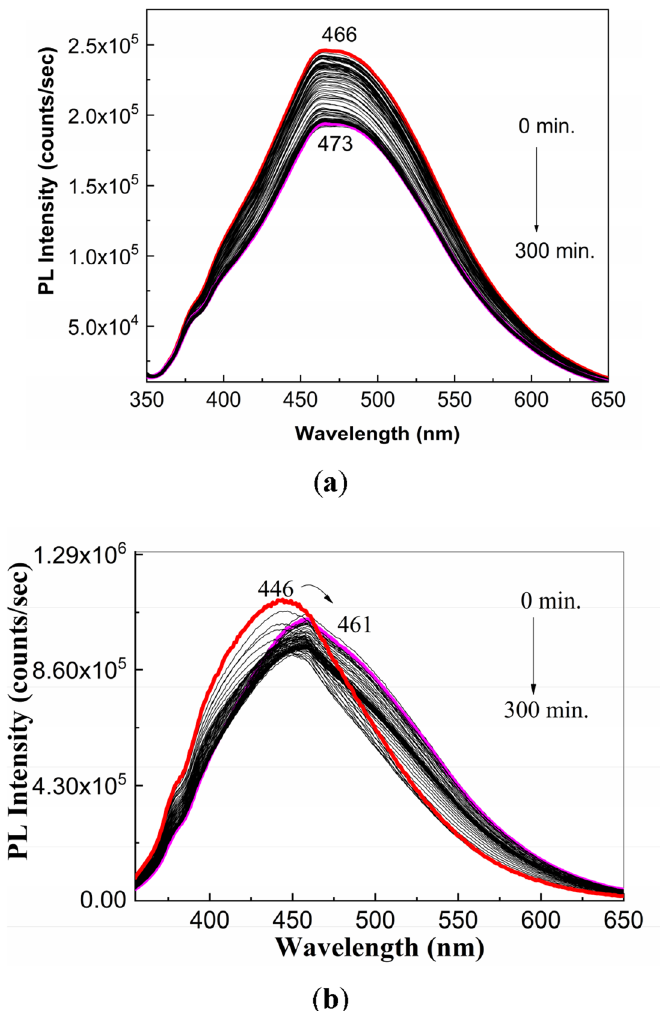
Figure 3. PL spectra of the aqueous solution of PS ( 1 , a ) and the Controloc drug ( 4 , b ), when the two samples are exposed to the UV light, for 300 min. The PS concentration in the two aqueous solutions was of 2 mg/ml. All PL spectra were recorded at the excitation wavelength of 335 nm. Red and magenta curves correspond to PL spectra of PS and Controloc, prior and after 300 min of UV light exposure, while the black curves show PL spectra successively recorded for the two